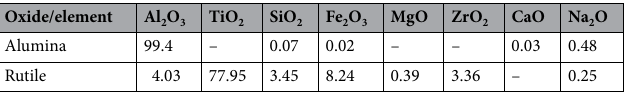
Table 1. Chemical composition, wt% of the starting materials.